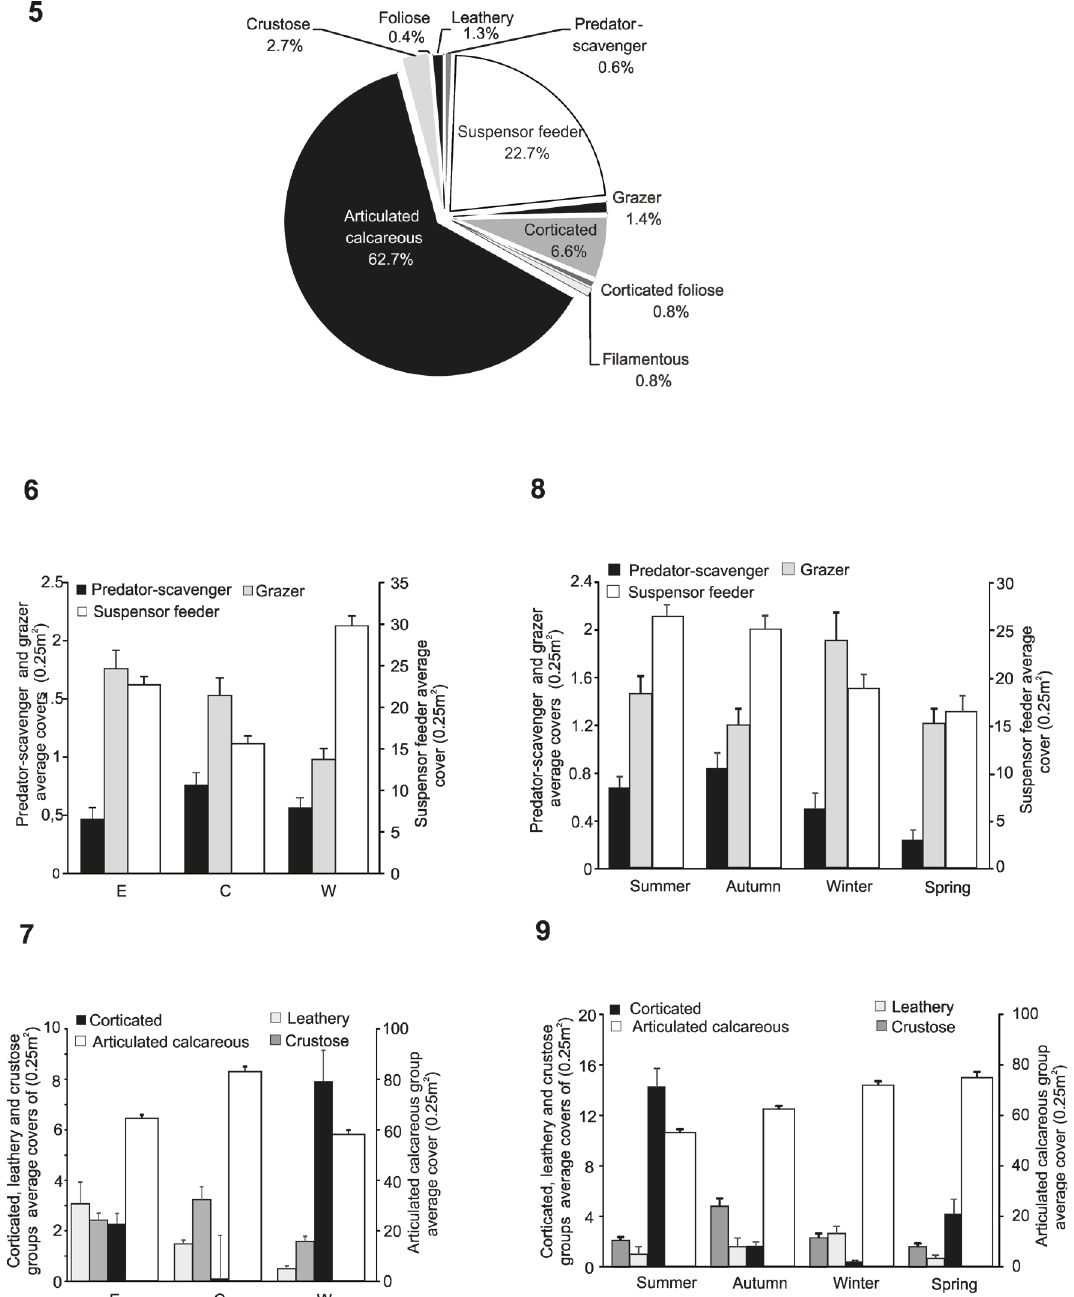
Figure 5. Distribution in abundance (cover %) of macroalgal morphological and invertebrate feeder functional groups during the whole sampling period. Figure 6. Distribution of abundance (cover %) of feeder groups in quadrats located at three different sampling sites (E: east; C: centre; W: west). Figure 7. Distribution of abundance (cover %) of algal morphological functional groups in quadrats located at three different sampling sites (E: east; C: centre; W: west). Figure 8. Distribution of abundance (cover %) of feeder groups over the seasons. Figure 9. Distribution of abundance (cover %) of algal morphological functional groups over the